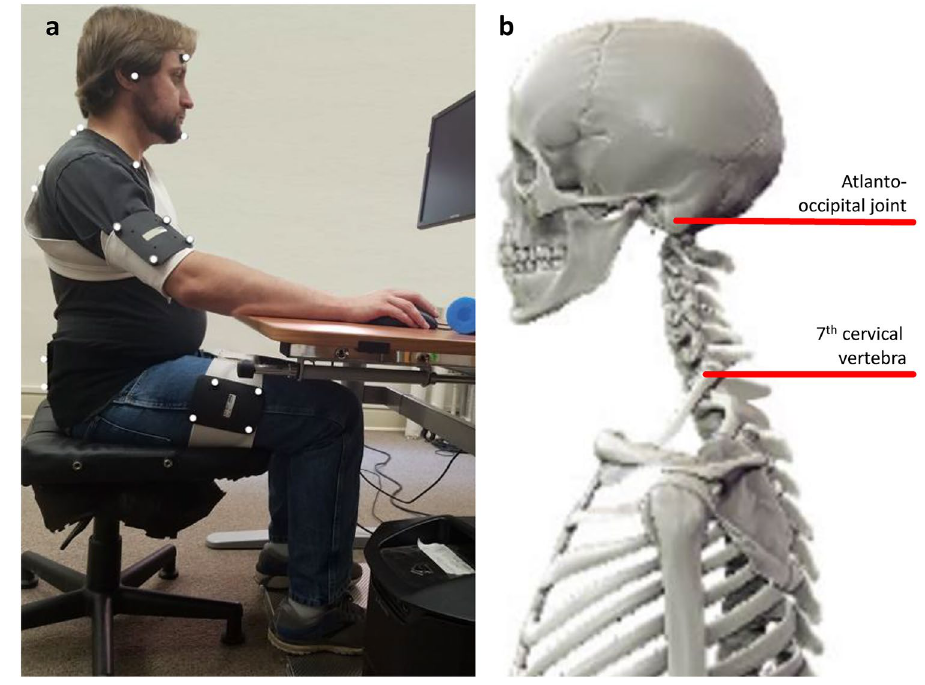
Fig. 1 Setup: a First author sitting at adjustable worksta- tion while wearing reflective marker clusters on the head, neck, upper torso, lower torso, left and right upper arm, and left and right thigh. b Compos- ite model showing offset posi- tions from surface landmarks for the atlanto-occipital joint and C7/T1